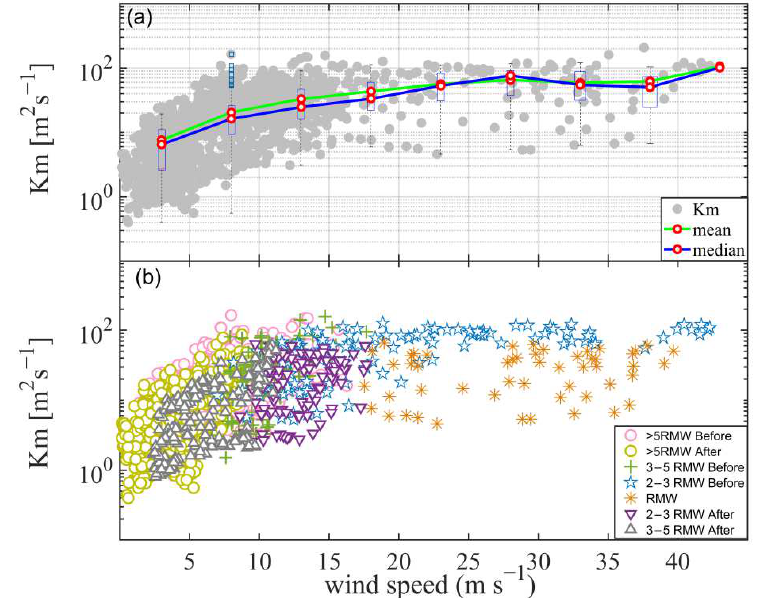
Figure 11. Vertical eddy diffusivity of momentum ( K m ) as a function of wind speed ( u n ). The blue line with the red circles is the bin median averaged K m at 5 m s −1 intervals of u n from the observations. The yellow line with the red circles is the bin mean averaged K m at 5 m s −1 intervals of u n from the observations ( a ). The data were classified into seven categories according to their distance from the typhoon center ( b